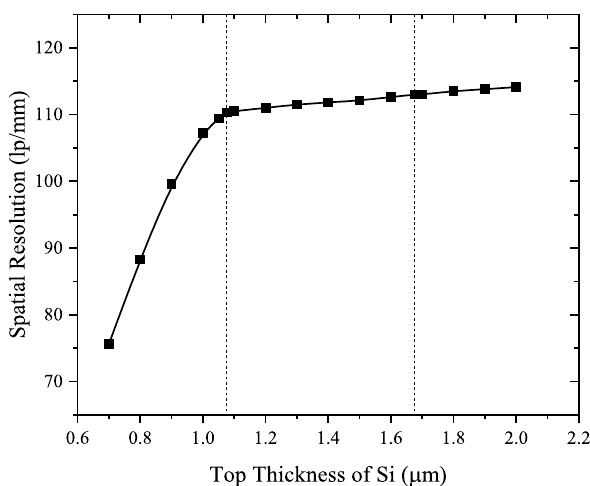
Figure 7. Spatial resolutions for the structured CsI(Tl) screens with different t Si .